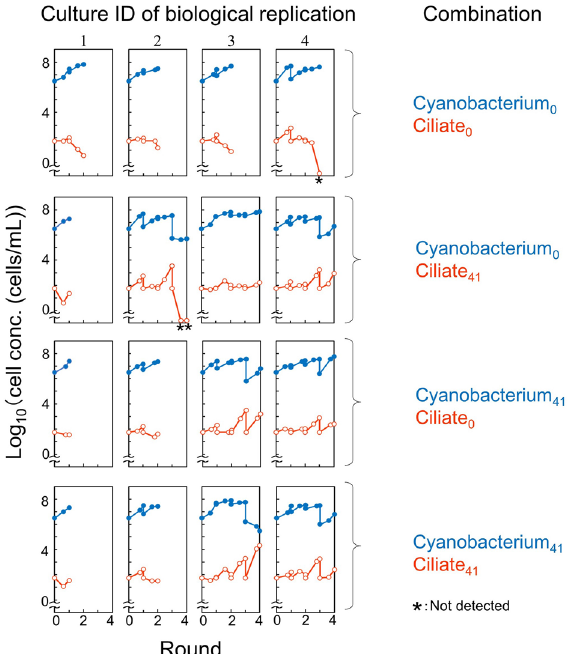
Figure 5. Improved sustainability through the serially transferred coculture. Growth curves of the cocultures of four possible combinations of the original (subscript 0) and evolved (subscript 41; isolated from round 41) cells of the cyanobacterium and ciliate (4 biological replicates are shown). The blue-closed and red-open circles correspond to the growth curves for the cyanobacterium and ciliate, respectively. The asterisks indicate that the ciliate was not